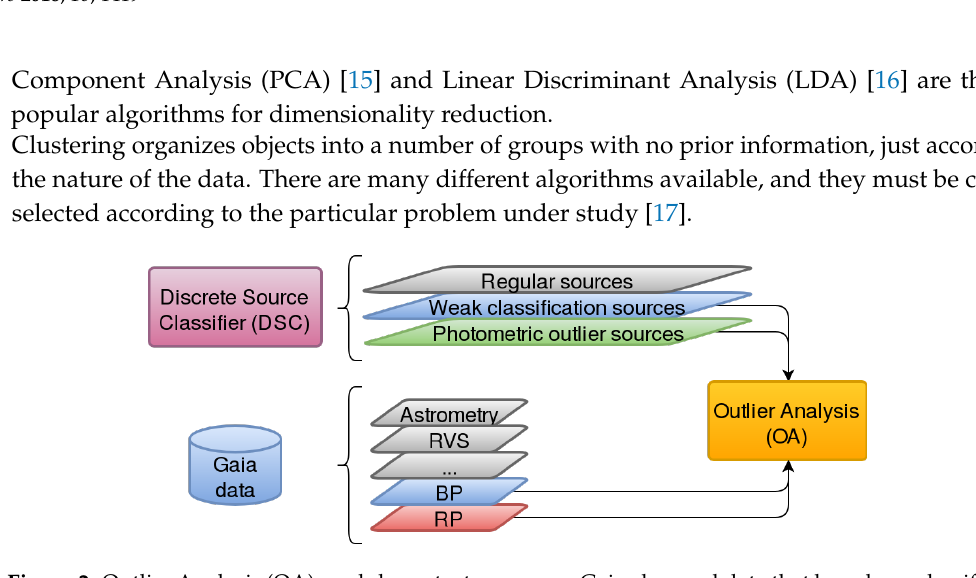
Figure 2. Outlier Analysis (OA) module context: processes Gaia observed data that have been classified as outliers by the Discrete Source Classifier (DSC)